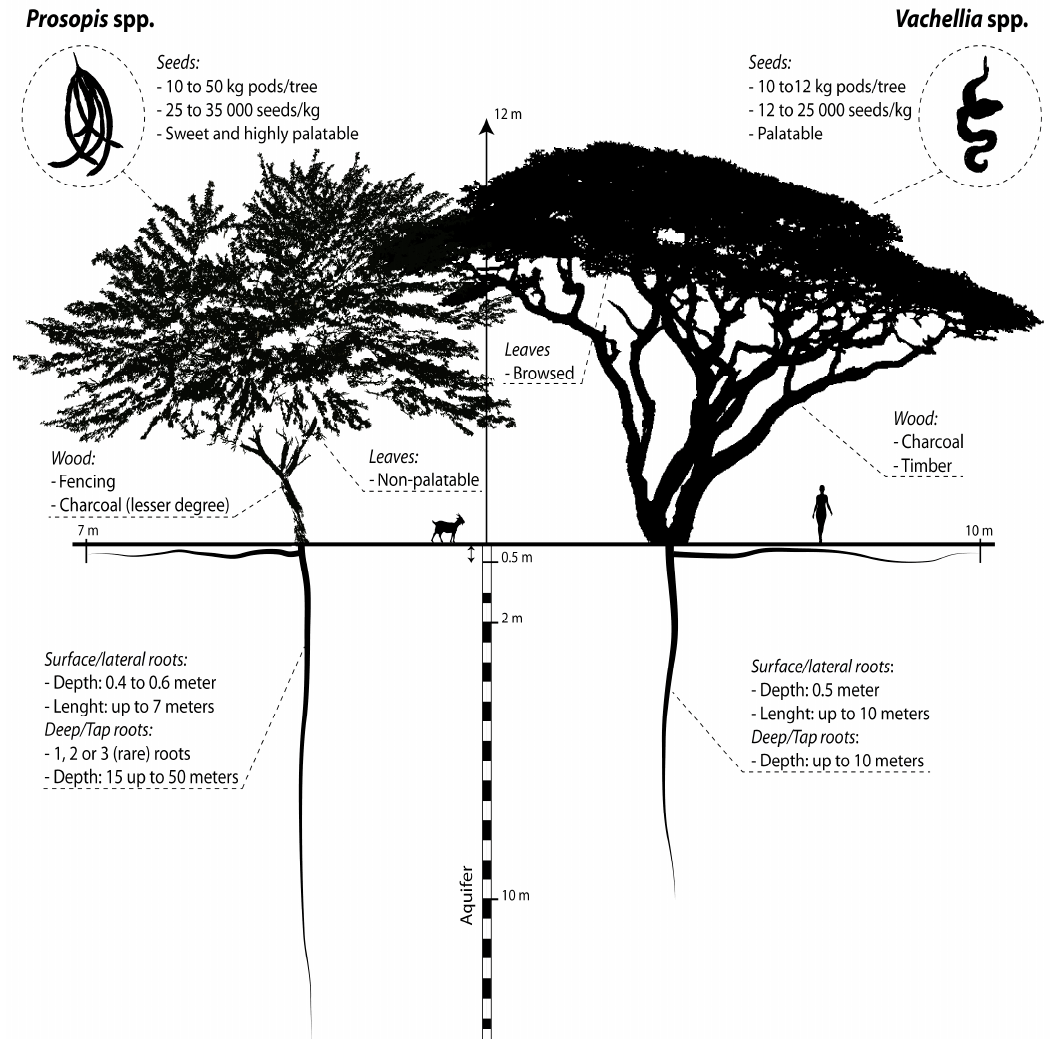
Figure 1. Generalization of the adaptations of Prosopis ( left ) and Vachellia ( right ) spp. [11,16,22,23], summarizing the competitive advantages of Prosopis in seed production, root system, leaf and pod palatability.